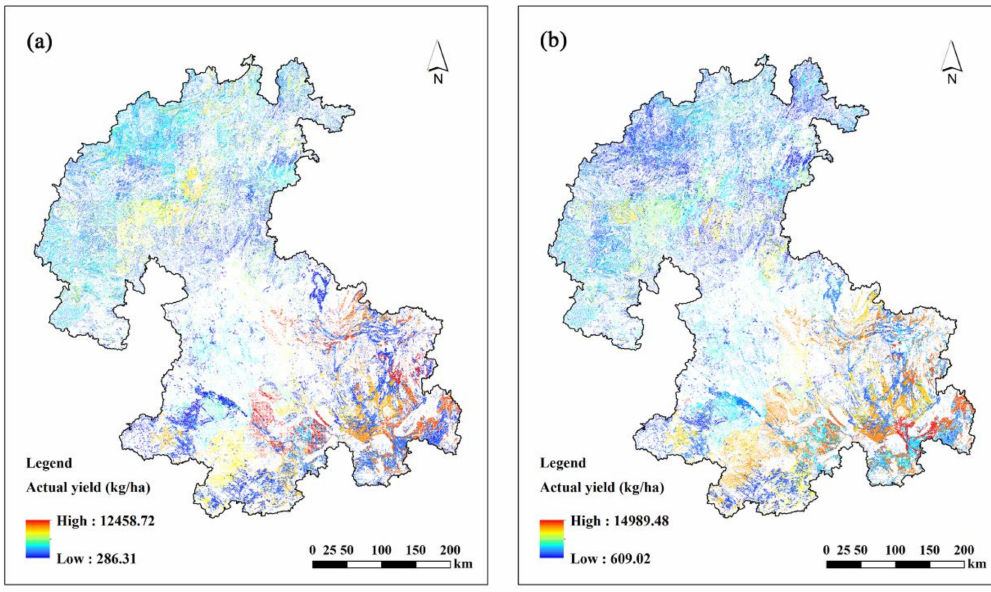
Figure 8. ( a ) The mixed actual grain crop yield in 2000; and, ( b ) the mixed actual grain crop yield in 2015.